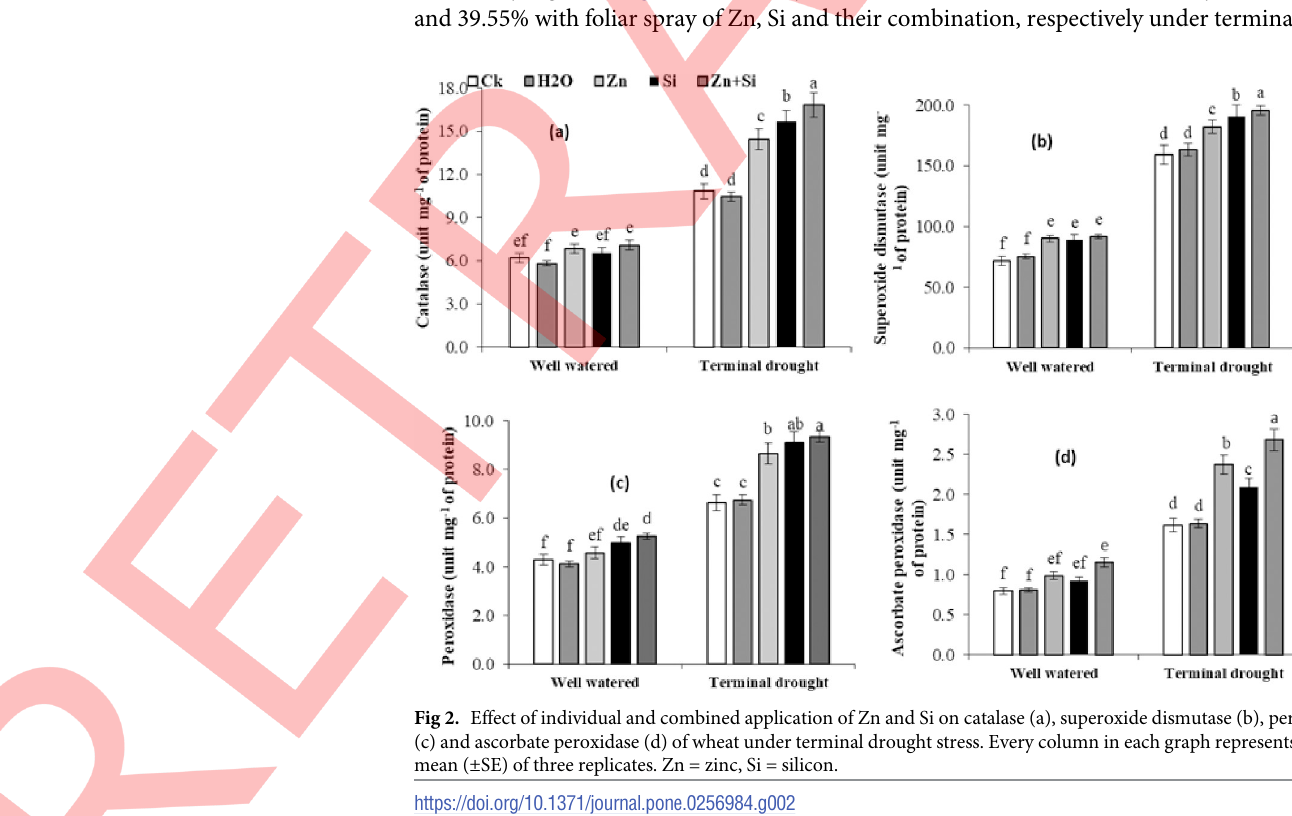
Fig 2. Effect of individual and combined application of Zn and Si on catalase (a), superoxide dismutase (b), peroxidase (c) and ascorbate peroxidase (d) of wheat under terminal drought stress. Every column in each graph represents the mean ( ± SE) of three replicates. Zn = zinc, Si =